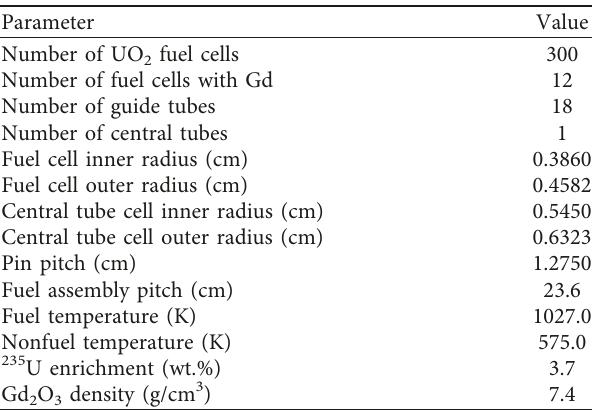
Figure 1: Configuration of the VVER-1000 LEU fuel assembly. Table 1: Main design parameters of the VVER-1000 LEU fuel